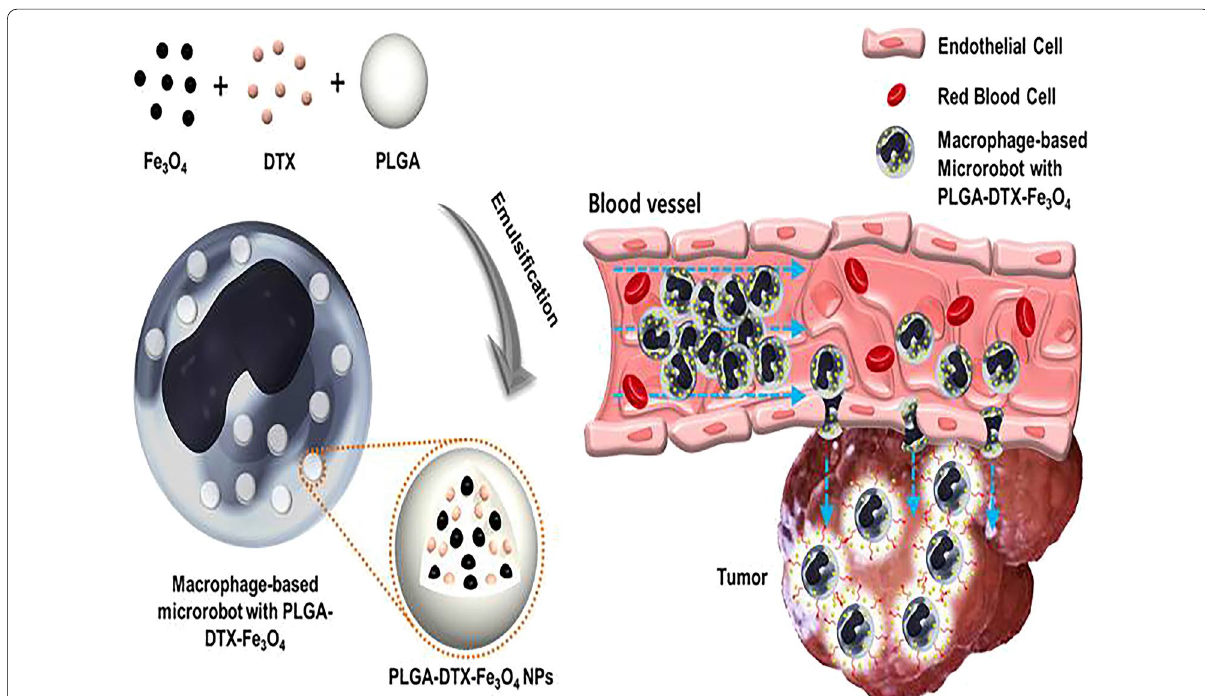
Fig. 3 Schematic diagram of the macrophage-based microrobot with PLGA-DTX-Fe 3 O 4 (left). Describe the targeting and treatment of tumors in the in vivo environment (right). Reprinted with permission from Ref. [20]. Copyright © 2016, Sci